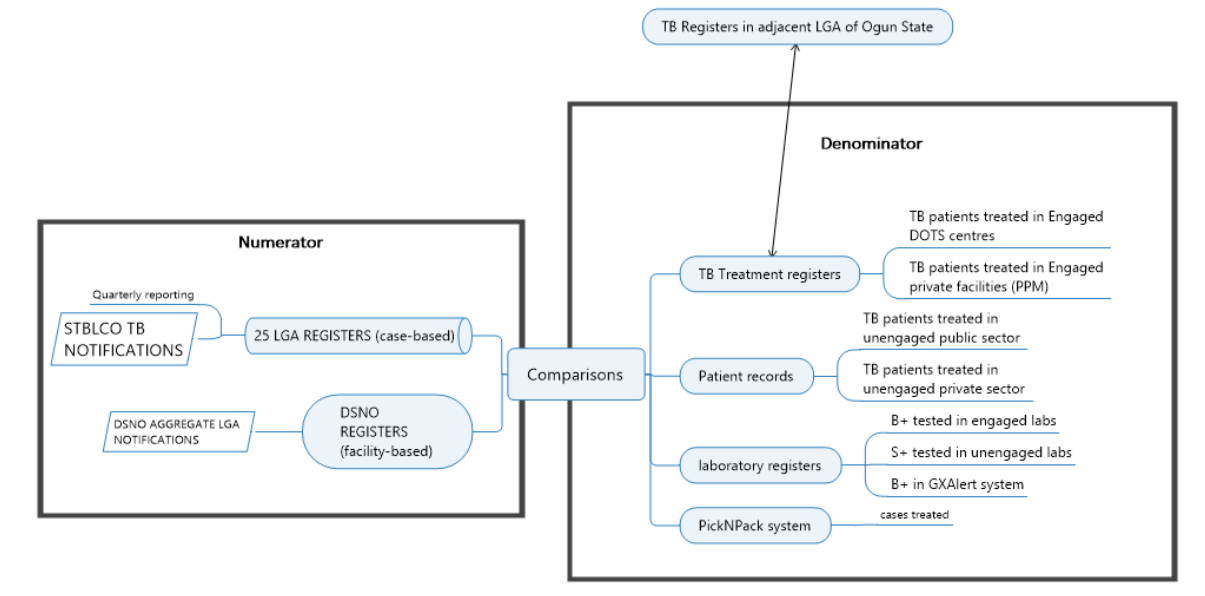
Figure 2. Map of primary data sources for the estimation of the magnitude of underreporting. B+: bacteriologically confirmed TB; DOTS: Directly Observed Treatment Short-Course; DSNO: disease surveillance and notification officer; LGA: local government area; PPM: public-private mix; S+ : smear positive; STBLCO: state tuberculosis and leprosy control officer; TB: